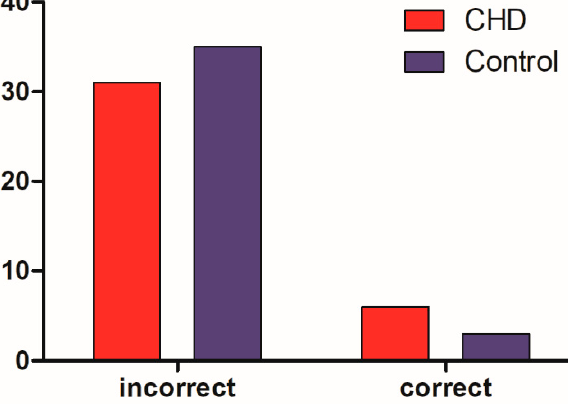
Figure 1. Children’s performance on the motor development scale . Table 2. Percentage of children with satisfactory performance in each of the motor tests .